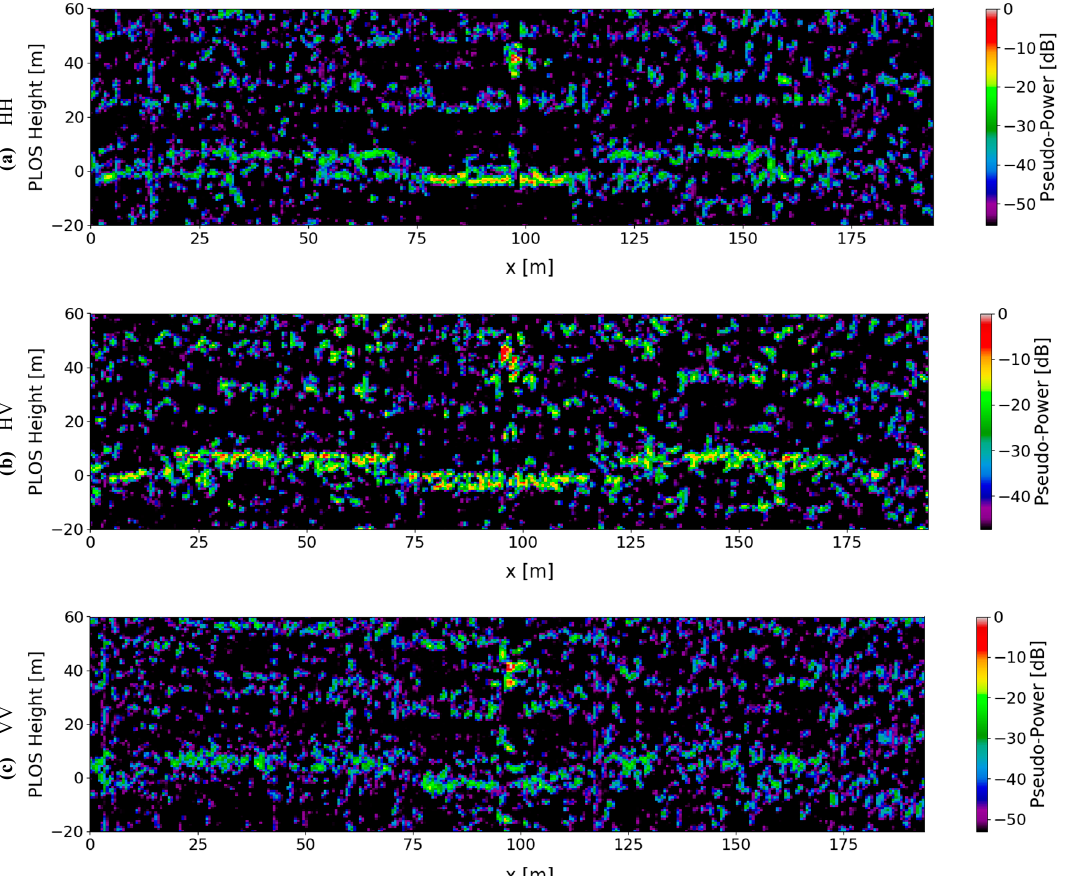
Figure 19. Tomograms retrieved from the area depicted by the blue line crossing the ROI specified in Figure 5. We perform focusing using DCRCB + WISE for three polarizations: ( a ) HH, ( b ) HV and ( c ) VV. We refer to the single-look case. All tomograms are normalized with respect to the (pseudo) power recovered by MSF.